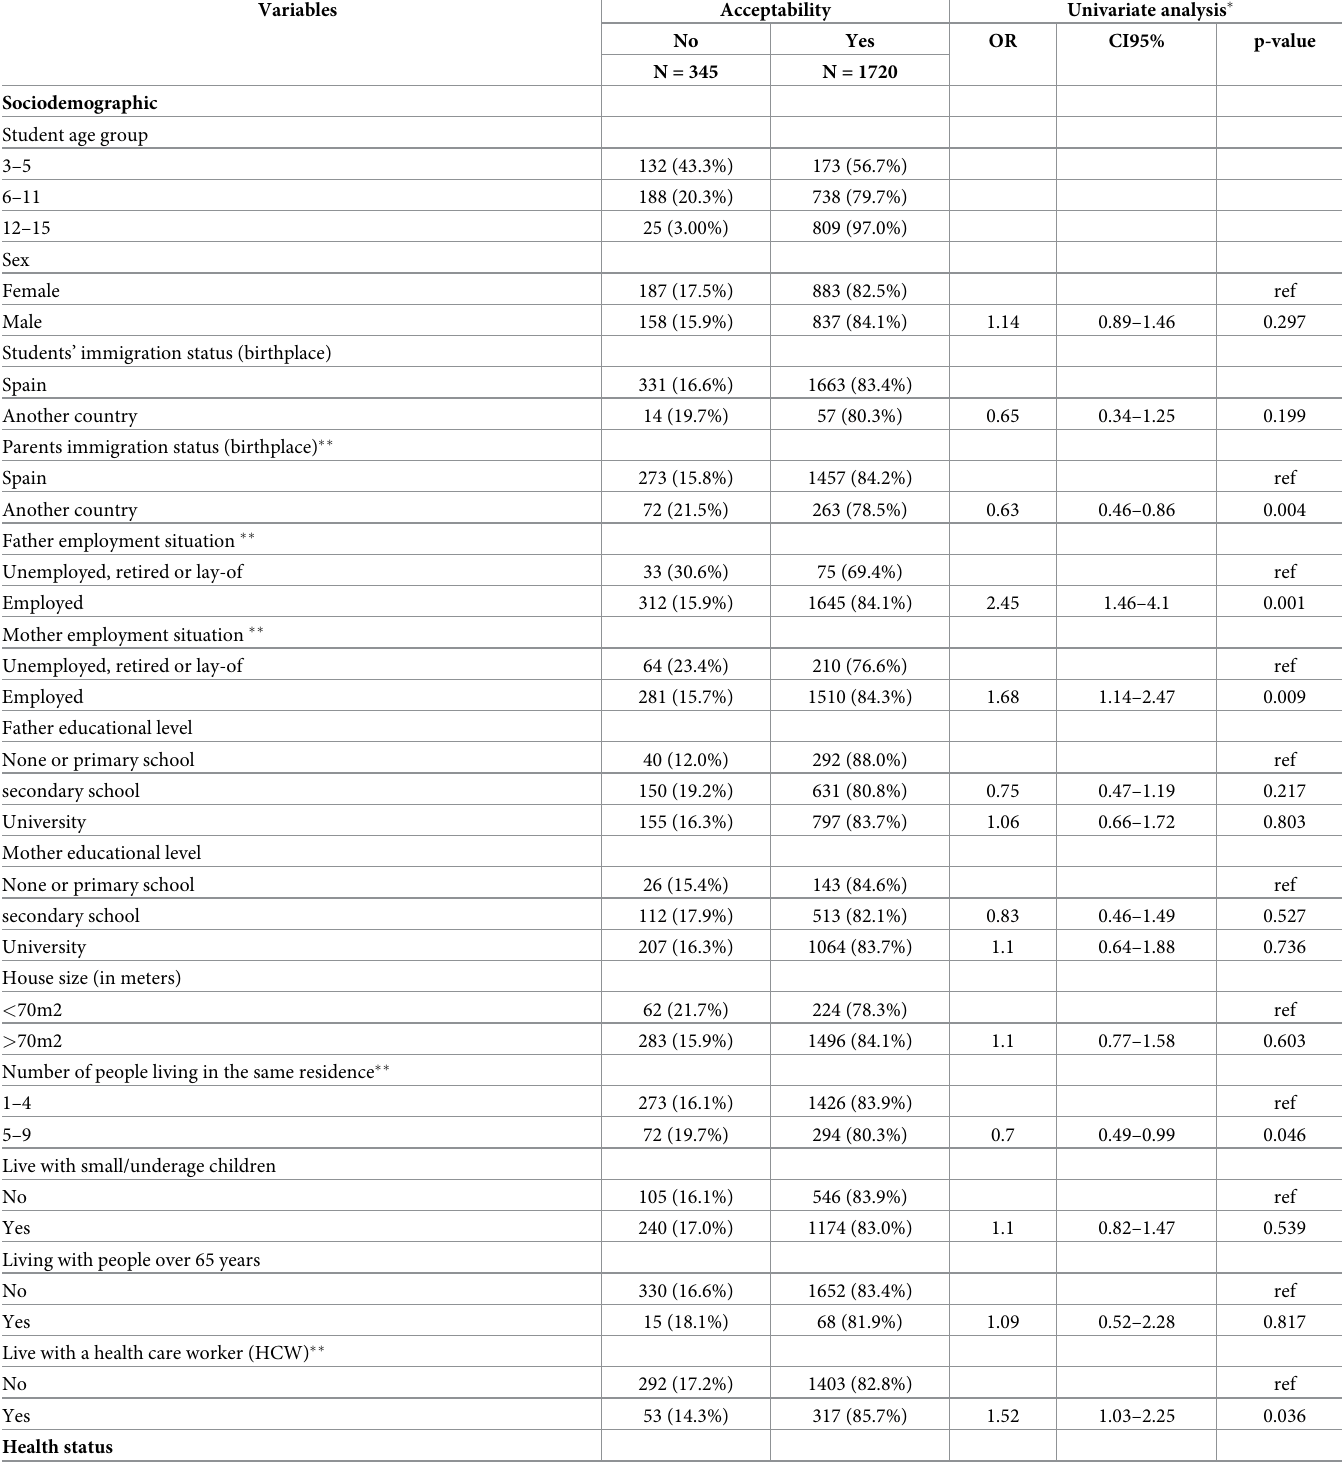
Table 4. Descriptive and univariate analysis between sociodemographic, health status, perception, attitudes and knowledge, behavior, COVID-19 related impacts and vaccine acceptability among parents of students under 16 years in SSNC. Catalonia, January